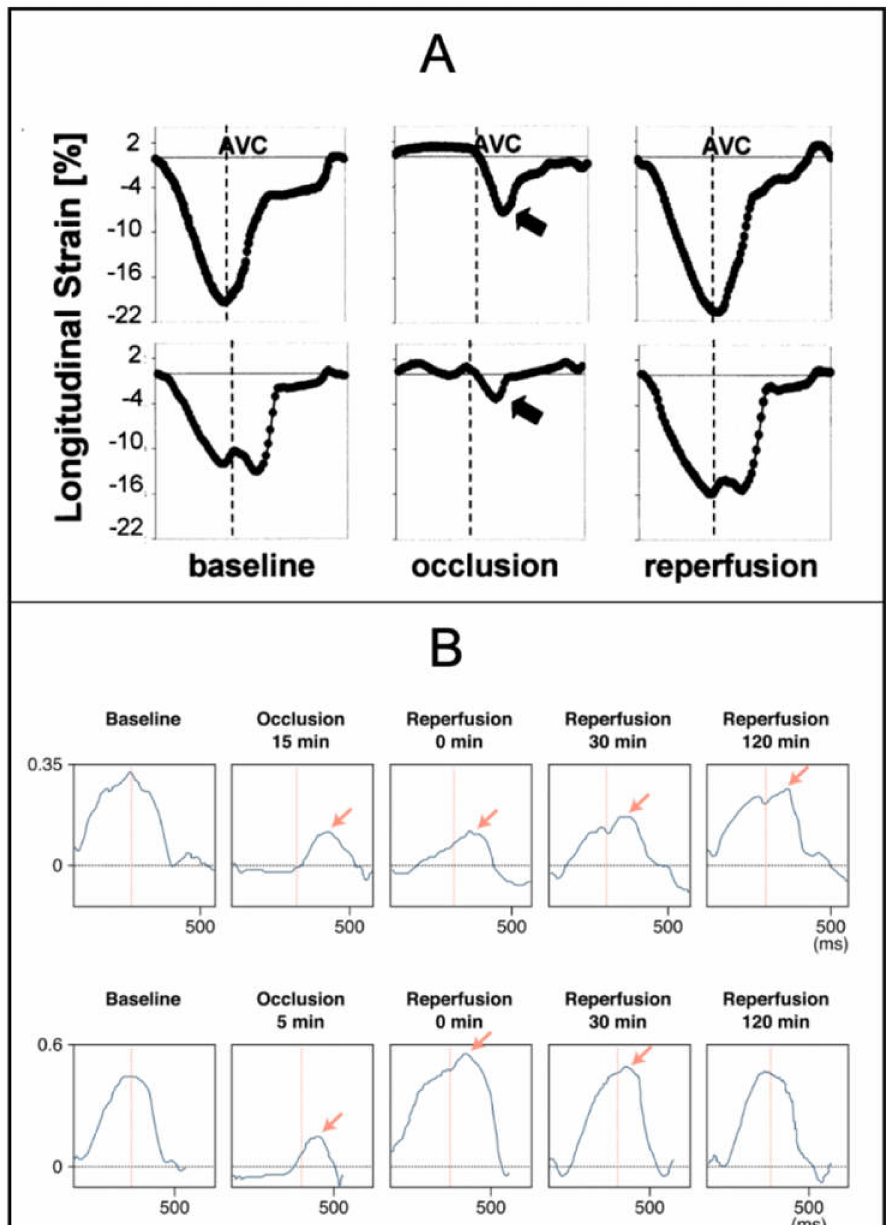
Figure 3. Deformation patterns during myocardial ischemia. Legend: ( A ) Longitudinal strain profiles in segment with normal wall motion (upper row) and segment with abnormal wall motion (lower row). Obtained before occlusion, 30 to 60 s after occlusion of LAD and 2 min after balloon reperfusion. The normal segment develops ESL and PSS after occlusion. The abnormal segment displays PSS at baseline, and the magnitude increases after occlusion. ( B ) Radial strain profiles of myocardial area exposed to 15 min (upper row) and 5 min (lower row) of coronary occlusion. Postsystolic thickening continues to appear after reperfusion in the segment exposed to 15 min of ischemia (indicating ‘ischemic memory’), whereas it disappears in the segment exposed to 5 min of ischemia. ( A , B ) are reprinted from Kukulski et al. [50] and Asanuma et al. [67] with permission from the American College of Cardiology (Elsevier). LAD: left anterior descending artery, AVC: aortic valve closure. PSS: postsystolic shortening, ESL: early systolic